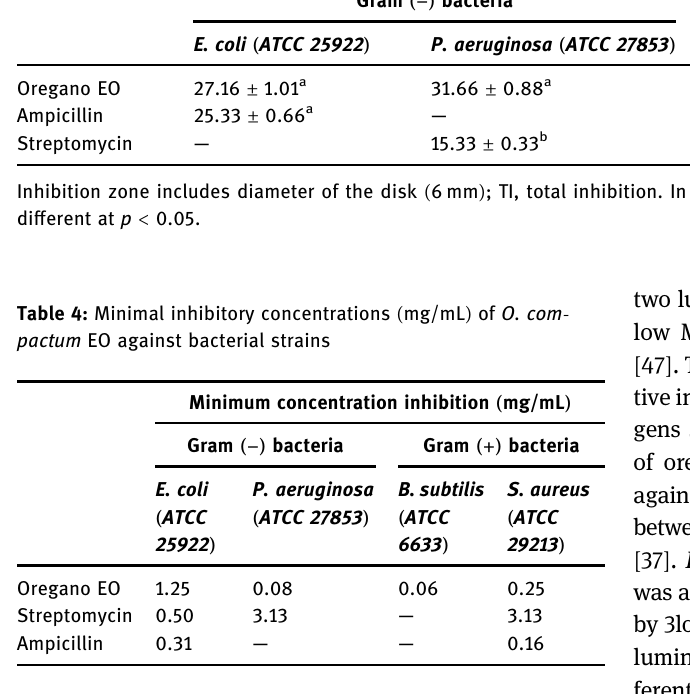
Table 3: Inhibition diameter ( mm ) of O. compactum EO against bacterial strains ( means ± SEM )